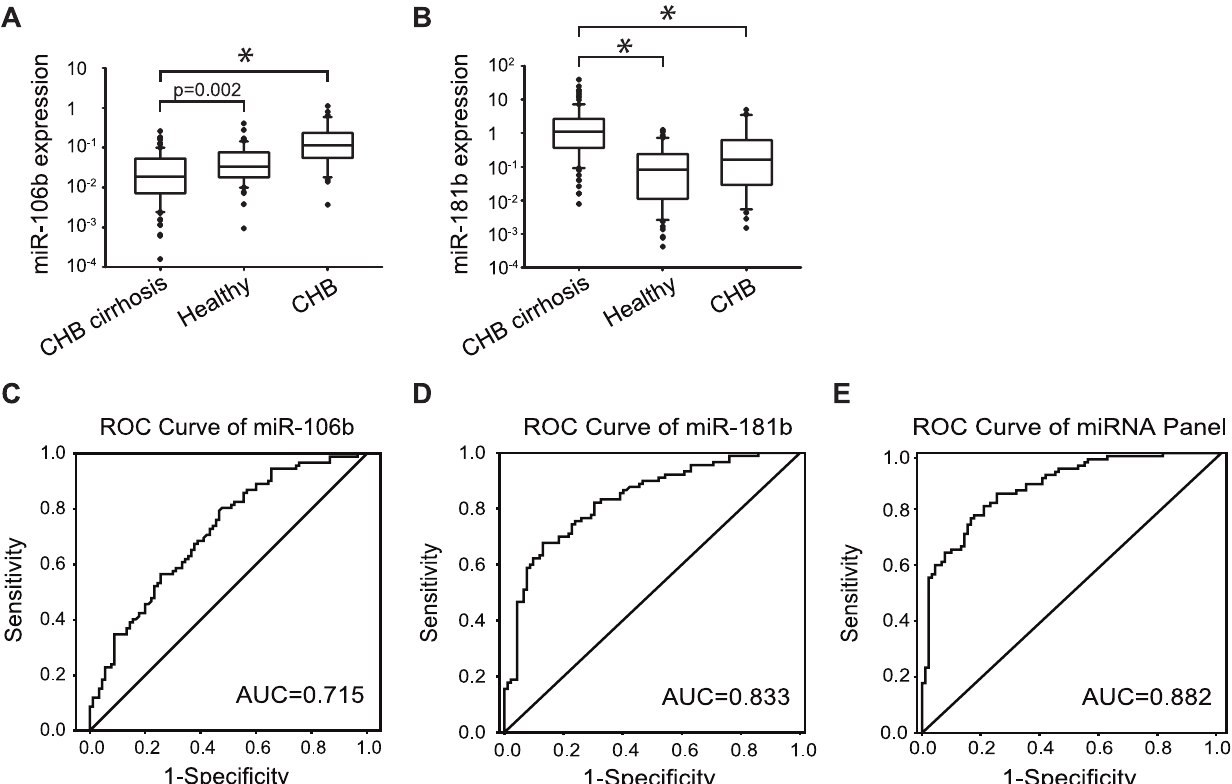
Figure 3. Plasma miR-106b and miR-181b levels are altered significantly in patients with CHB cirrhosis in the training phase. Plasma miR-106b (A) and miR-181b (B) levels were measured in 182 samples by qPCR. Mann Whitney U test was used to determine statistical significance. Represented in the box plots are median, interquartile range, and the data range. ROC curve analysis showed the diagnostic power of miR-106b (C), miR-181b (D), and the miRNA classifier (E). *P , 0.05.